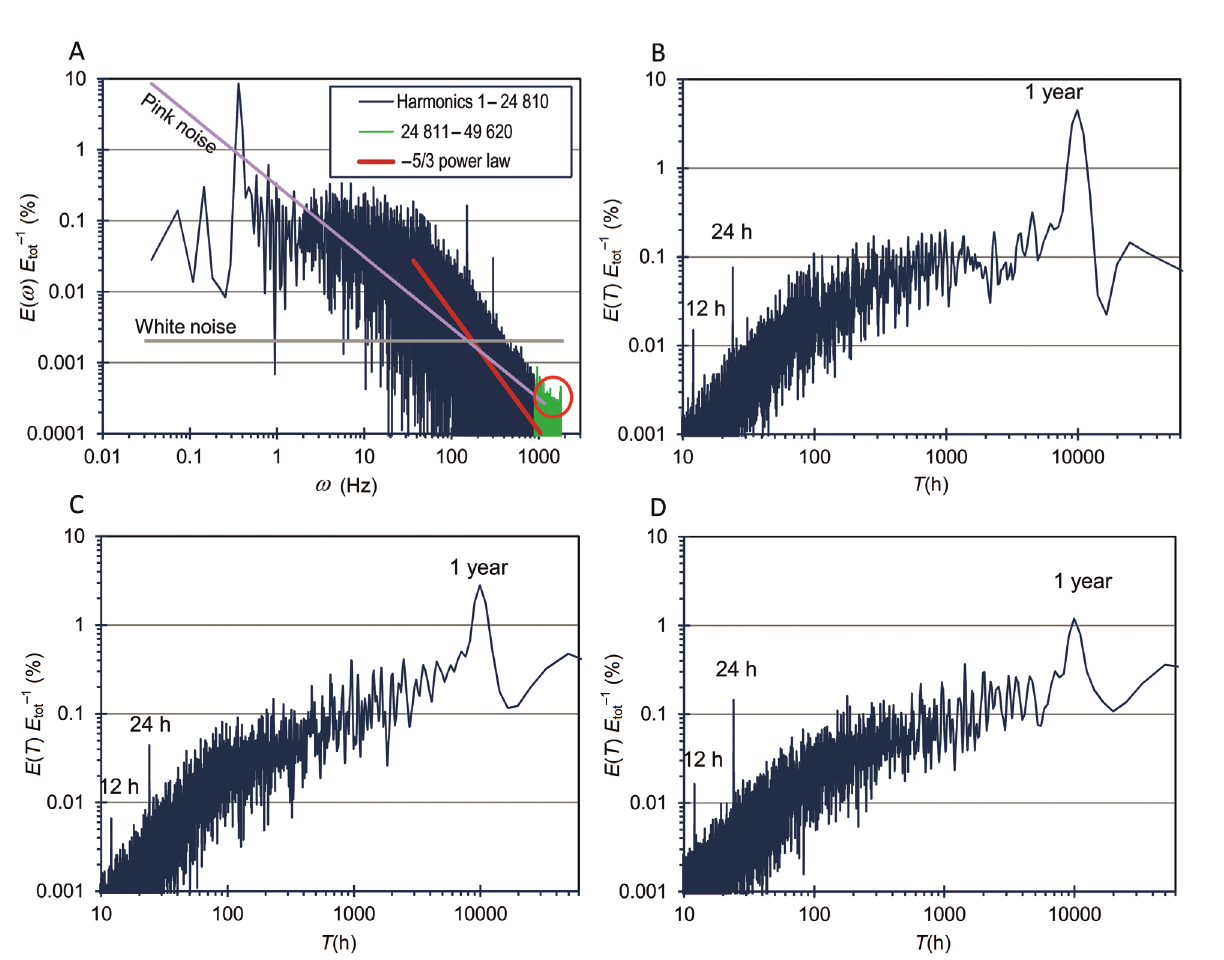
Fig. 6. The normalized energy spectra at Kõiguste ( A , periodogram, a function from frequency ω ; B , energy density spectrum, a function from period T ); energy density spectra at Harilaid ( C ) and Suurupi ( D ) together with some characteristic peaks and slopes of background spectra. The red circle (in A ) indicates the influence of aliasing.